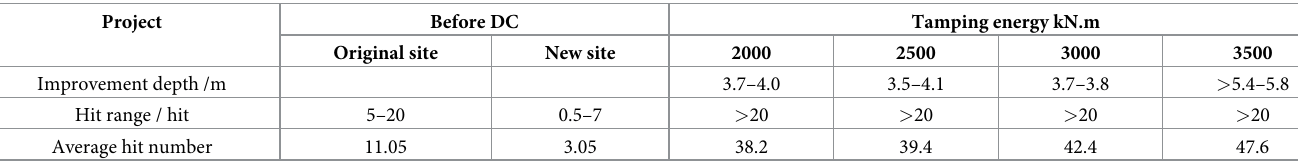
Table 4. Heavy dynamic penetration test results.